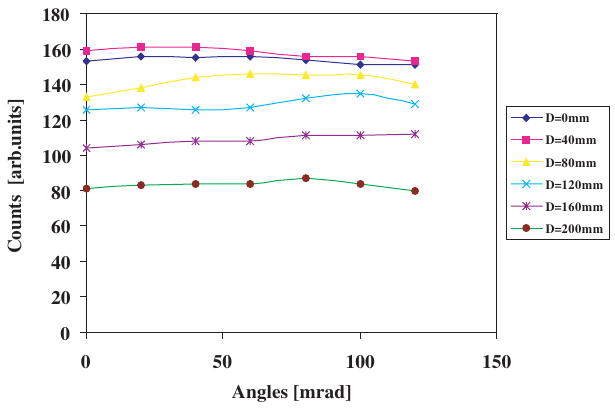
FIG. 5. (Color) PM efficiency as a function of the position and of the angle of incidence of the blue LED light on the PM active